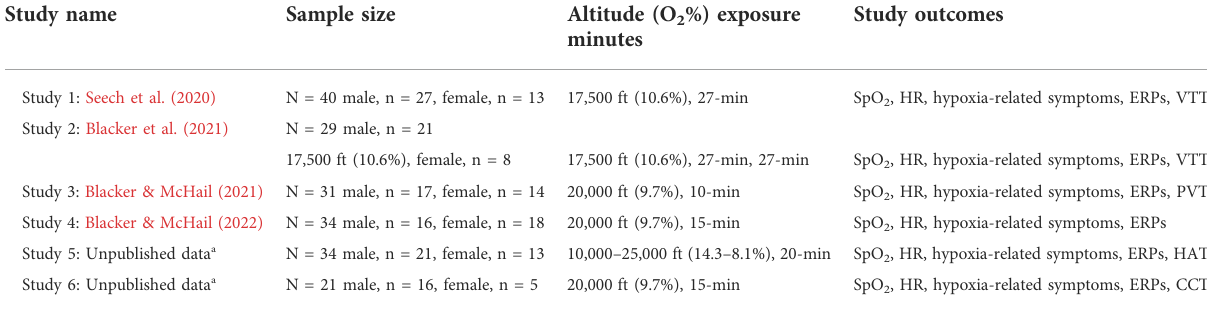
TABLE 1 Hypoxia studies for retrospective